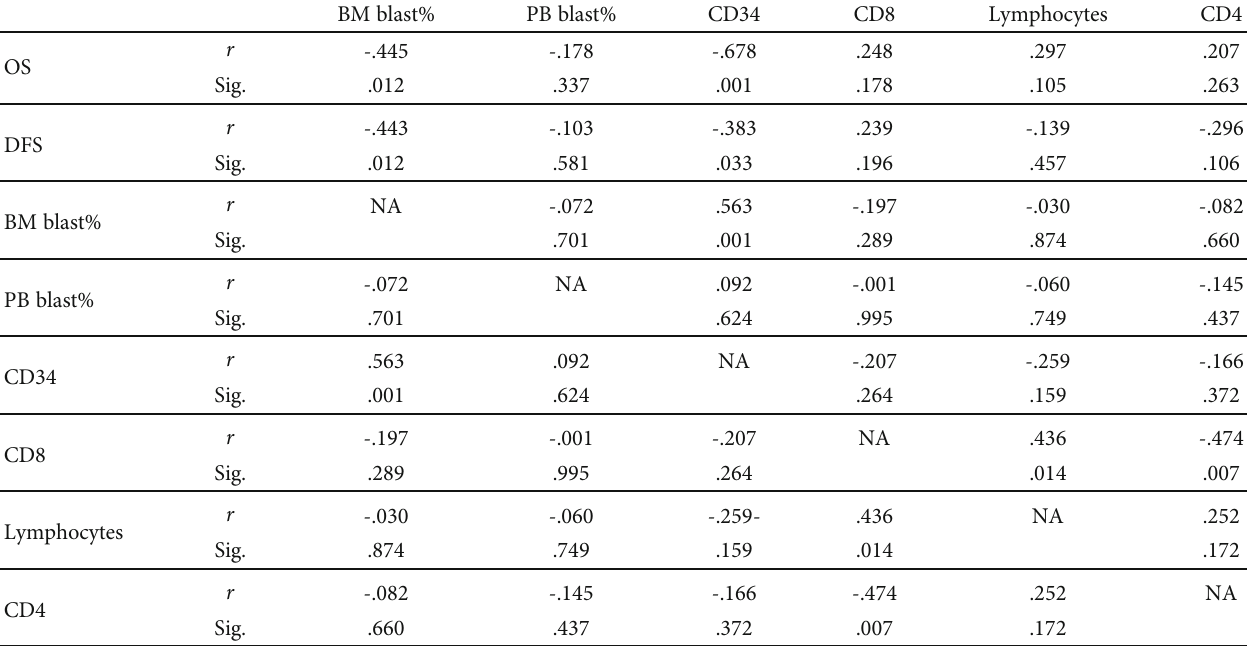
Table 5: Correlations between survival functions and di ff erent prognostic factors.